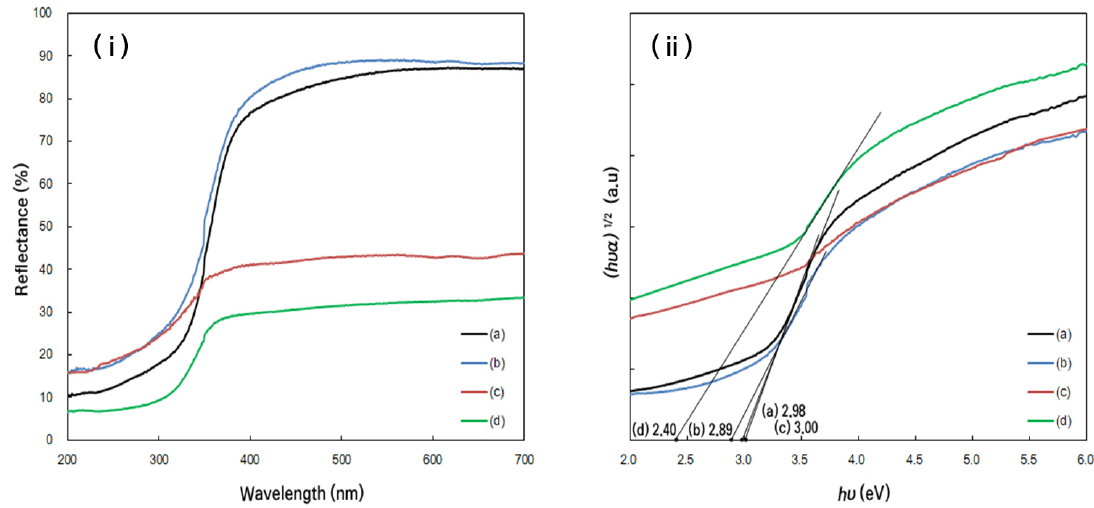
Figure 9. ( i ) UV-visible diffuse reflectance spectrum and ( ii ) Kubelka–Munk plots of the calcined samples; (a) S2 (550) (b) S2 (800) (c) S4 (550) and (d) S4 (800). samples; (a) S2 (550) (b) S2 (800) (c) S4 (550) and (d) S4